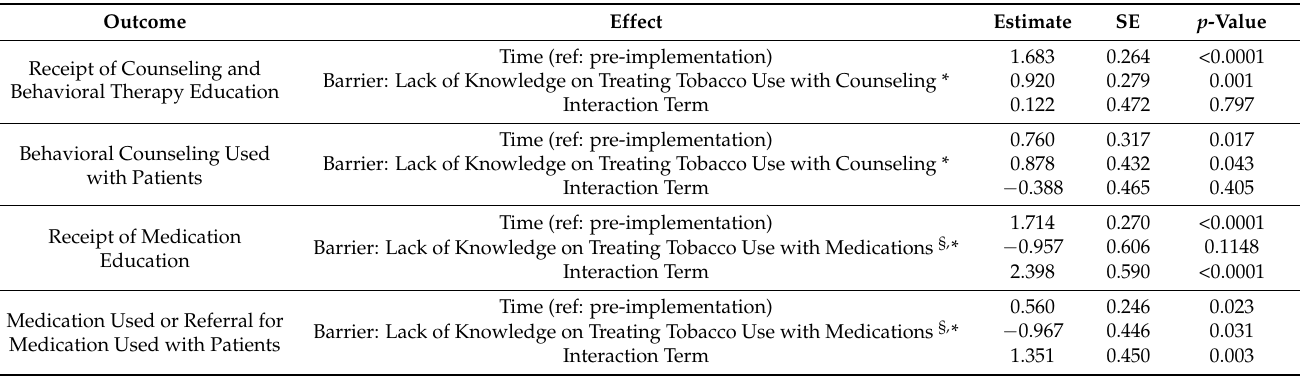
Table 4. Examination of center-level changes in lack of knowledge as a barrier to care provision as a moderator of changes in provider-reported receipt of education and provider-reported intervention practices from before to after the implementation of a comprehensive tobacco-free workplace program in 15 Texas substance use treatment